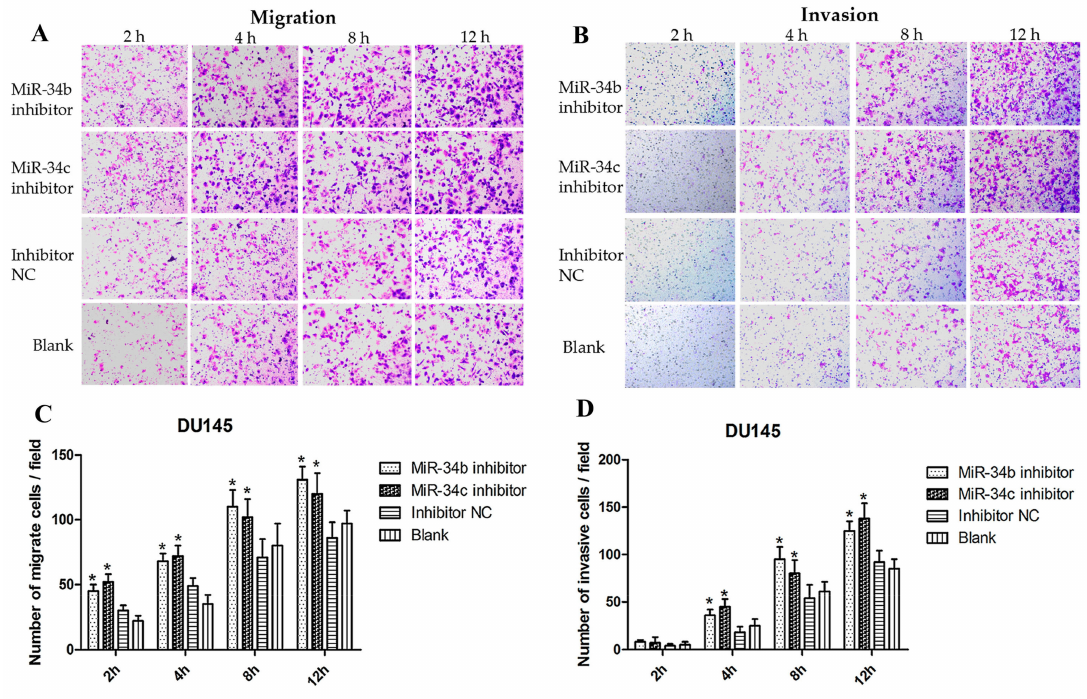
Figure 8. The migration and invasion capacity after transfection with miR-34b/c in DU-145 cells at 2, 4, 8, 12 h respectively. ( A , B ) Representative images showing the invasion and migration of DU-145 cells transfected with miR-34b/c inhibitor or inhibitor NC or without transfection (20 × objective); ( C , D ) Quantitative analysis of cell migration and invasion. * p < 0.05 vs. inhibitor NC or blank group. Per condition, three independent experiments were